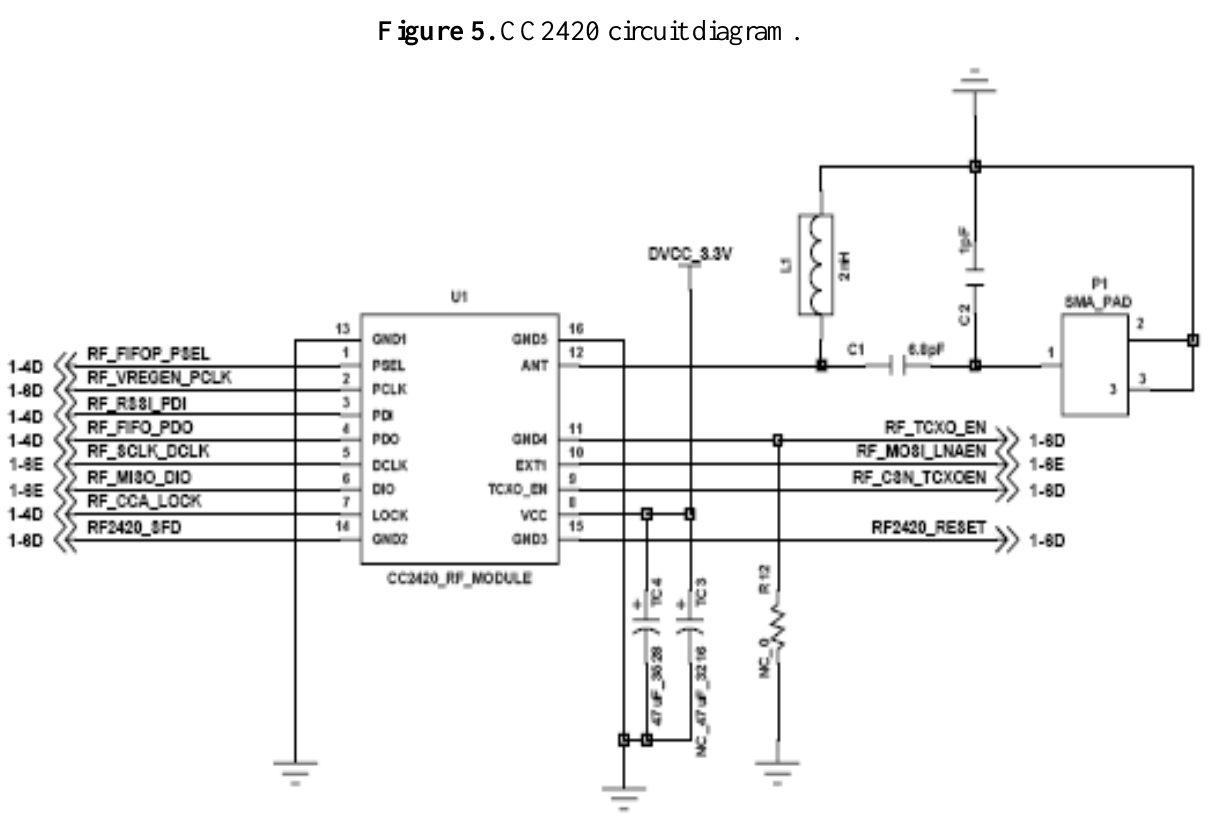
Figure 5. CC2420 circuit diagram.